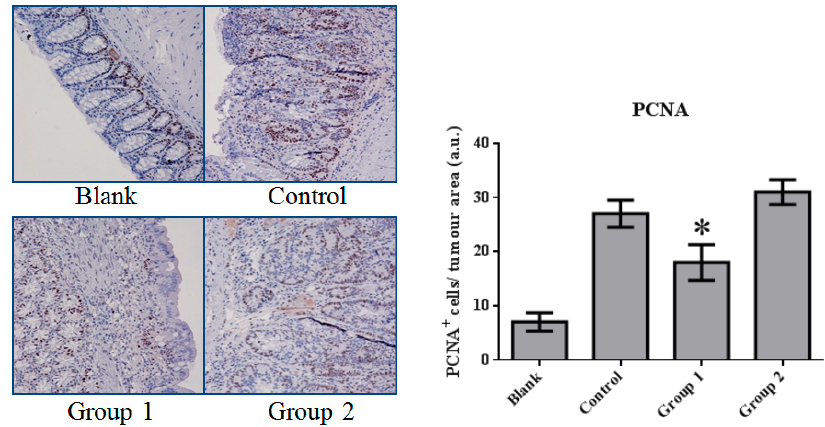
Figure 5. The expression of Proliferating Cell Nuclear Antigen (PCNA) in colorectal tissue. PCNA expression was significantly inhibited by ASR extract treatment in the initial stage (Group 1). The amount of sample in each group was n = 8 (blank group), n = 6 (control group), n = 7 (Group 1), n = 7 (Group 2). p > 0.05 and * p < 0.05 when compared with the control group.